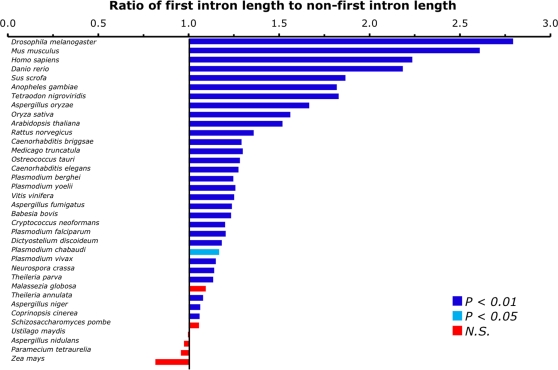
First introns are the longest introns in most species.Results shown for all species in GenBank release 164 which have at least 500 CDSs that specify multiple introns. Z-tests were used to determine significance and color denotes level of significance (see legend, N.S. = not significant).